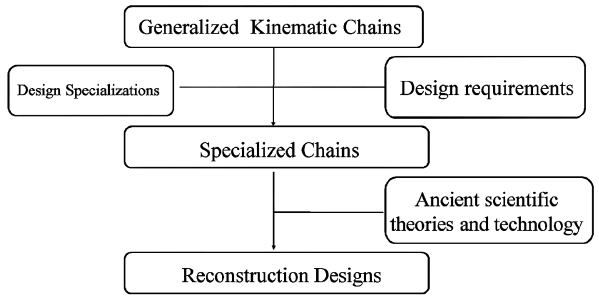
Figure 9. Process of reconstruction design (Yan,